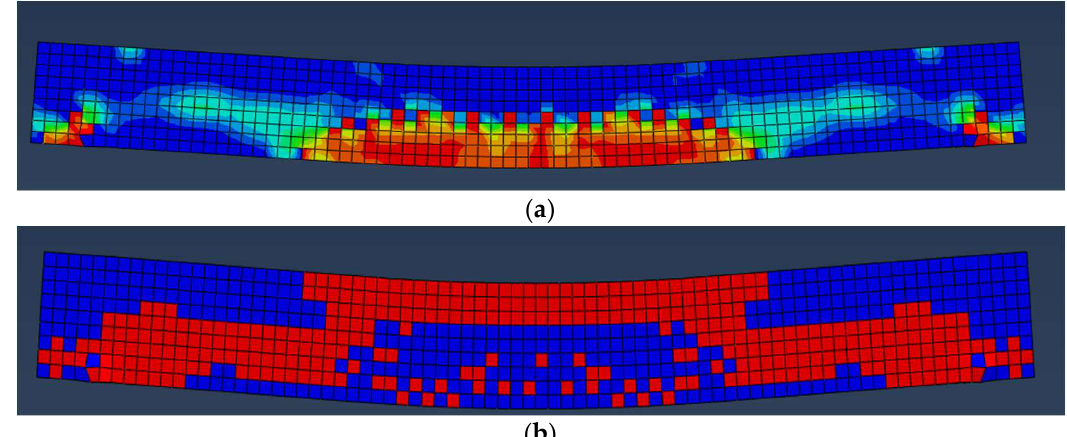
Figure 24. Analytical damage pattern of LWCM3. ( a ) Tensile damage of LWCM3; ( b ) Yield points Figure 23. Analytical damage pattern of LWCM2. ( a ) Tensile damage of LWCM2; ( b ) Yield points of LWCM3. of LWCM2.